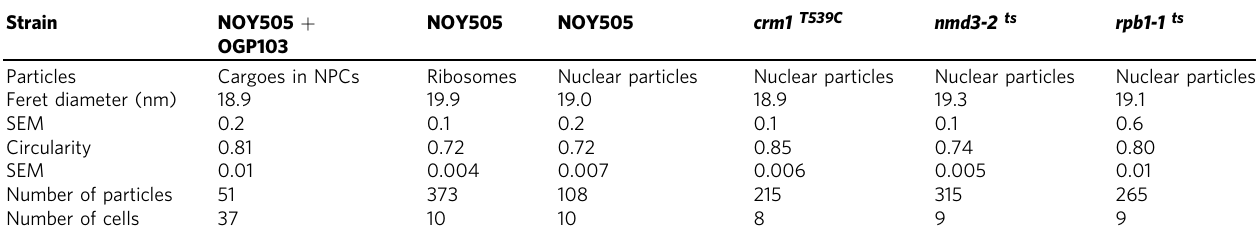
Table 2 Morphological comparison of the RNP particles found in NPCs with ribosomes and pre-ribosomal particles